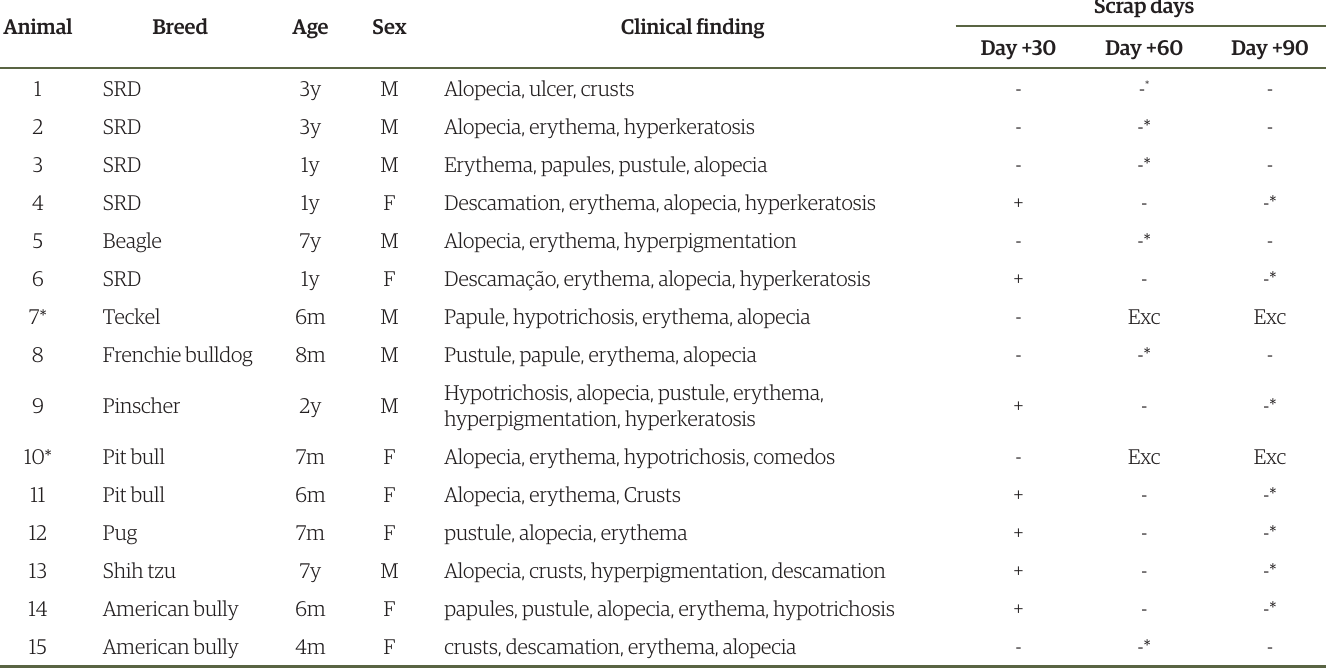
Table 1. Clinical presentation of dogs diagnosed with demodicosis evaluated until parasitical cure.